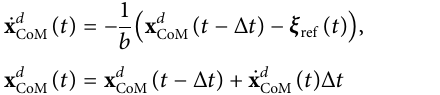
Frontiers in Robotics and AI |